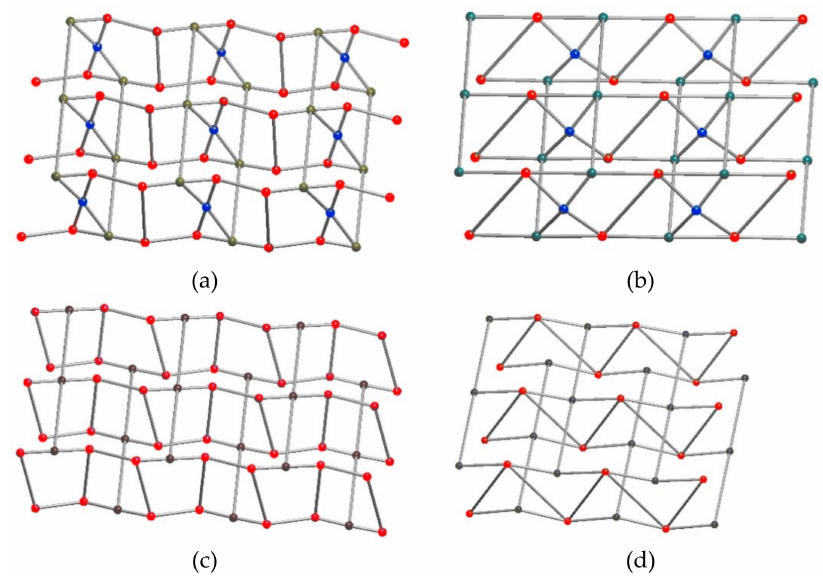
Figure 3. Schematic representation of; ( a ) 4 nodal network with two 3, one 4 and one 5 connected vertexes; ( b ) 3-nodal net with 4, 4, 5-connected vertex; ( c ) 4,4L62 and; ( d ) 3,4L156. The Cu1 node is represented in dark green, Cu3 in blue and P nodes in